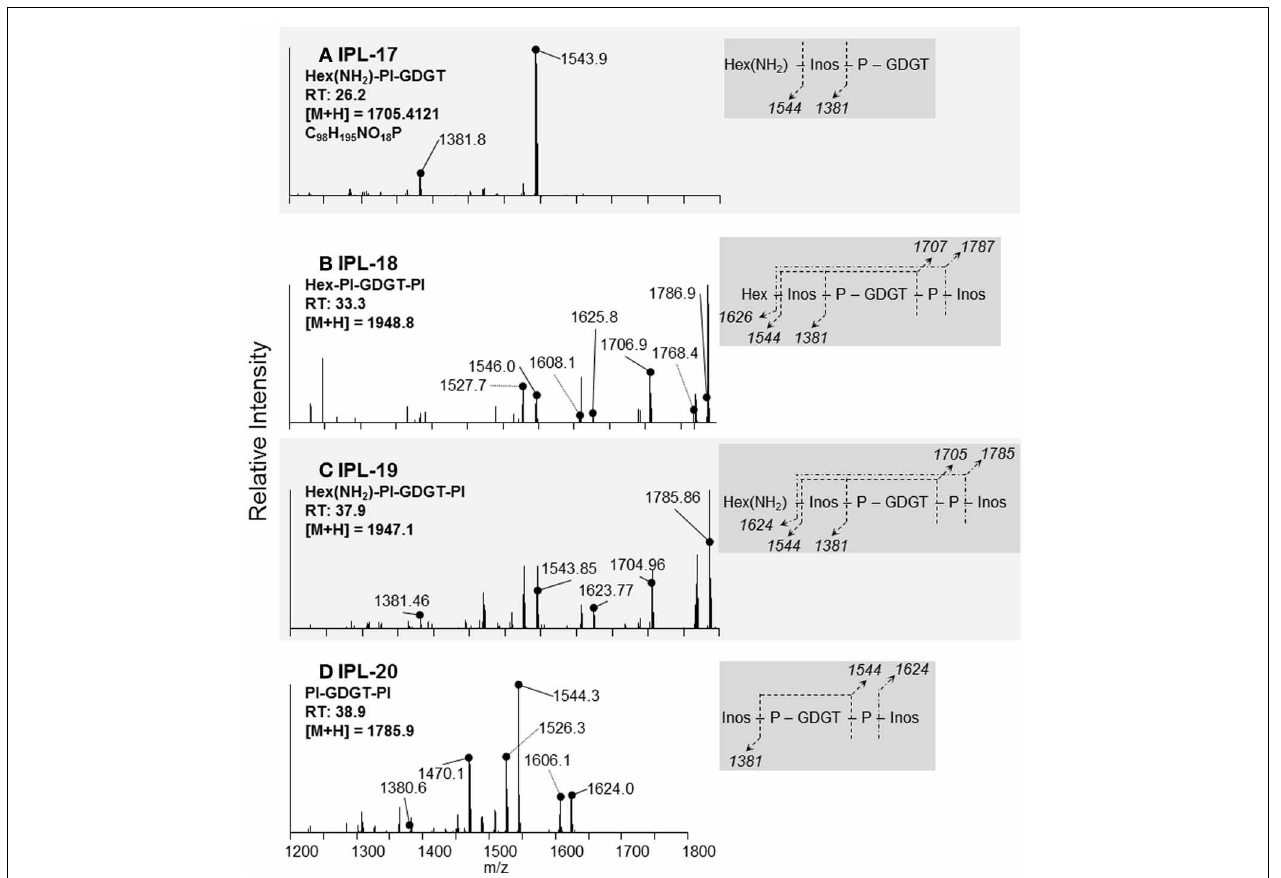
FIGURE 5 | Identification and tentative structural assignment of novel GDGT IPLs produced by T. kodakarensis . IPLs containing a GDGT core lipid were deduced via fragmentation patterns, retention times, and parent ion masses identified after ion trap-MS and Q-TOF-MS. Expected mass losses of known headgroup moieties are illustrated in the dark gray box and correspond to daughter ions identified in the MS/MS spectra. The daughter ions labeled with dotted lines in the MS/MS spectra refer to a loss of water (18Da) from fragments identified in the